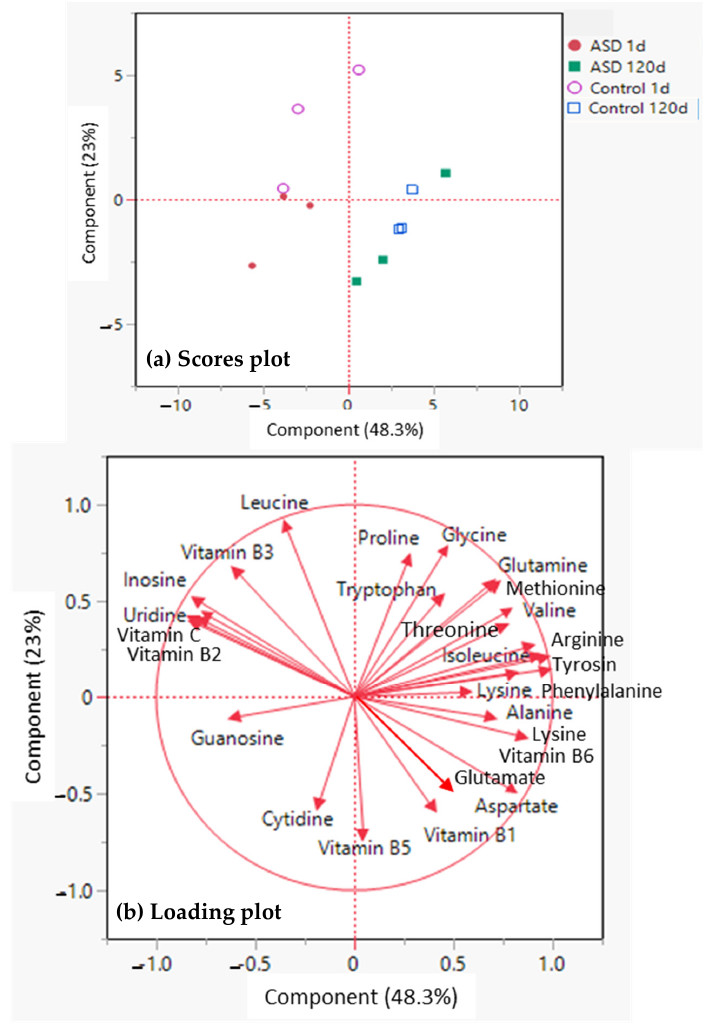
Figure 3. Principal components analysis (PCA) of 6 vitamins, 17 amino acids, and 5 nucleosides in winter melon juice samples extracted from ASD treated or control fruit that were stored at 20 °C for 1 or 120 d. ( a ) Scores plot and ( b ) Loading plot.